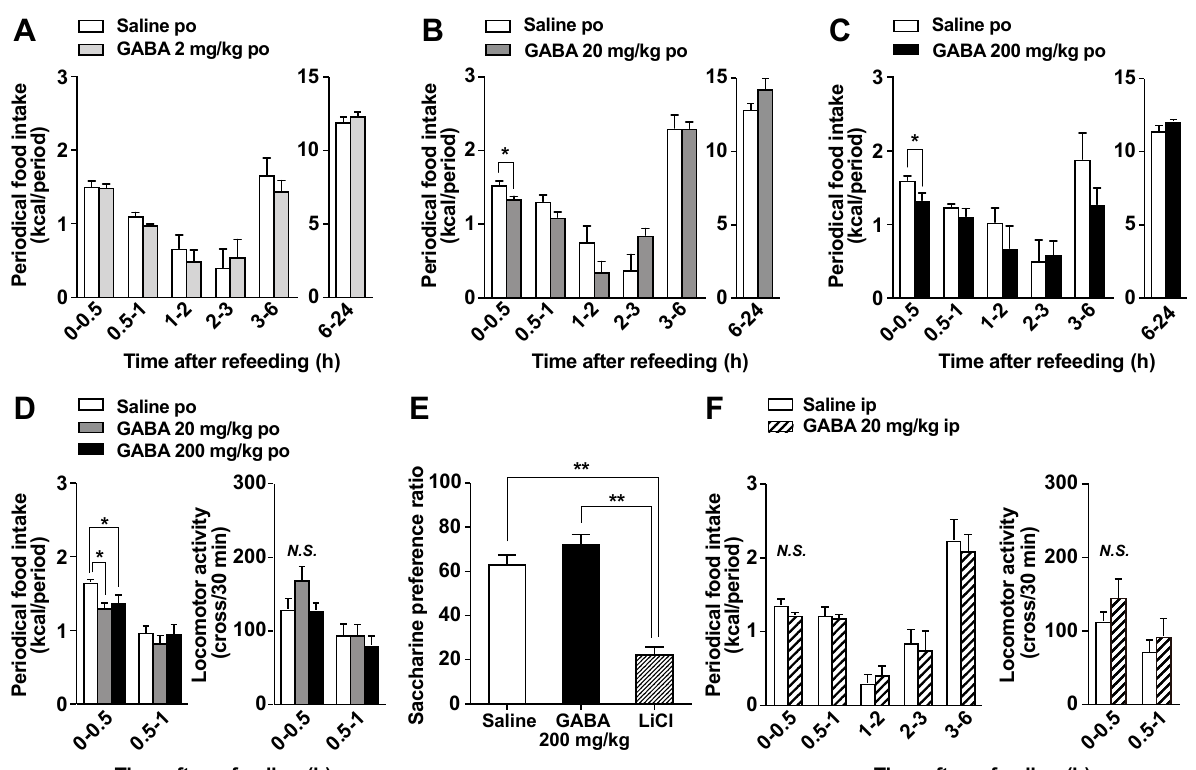
Figure 2. Po GABA administration immediately before the start of refeeding suppresses food intake in a dose-dependent manner without aversive behaviors. ( A – C ): Periodic food intake in response to the po administration of GABA at 2 ( A ), 20 ( B ), or 200 mg/kg ( C ) or saline immediately before refeeding in mice fasted overnight (16 h). Periodic food intake (kcal) for 0–0.5 h after GABA injection